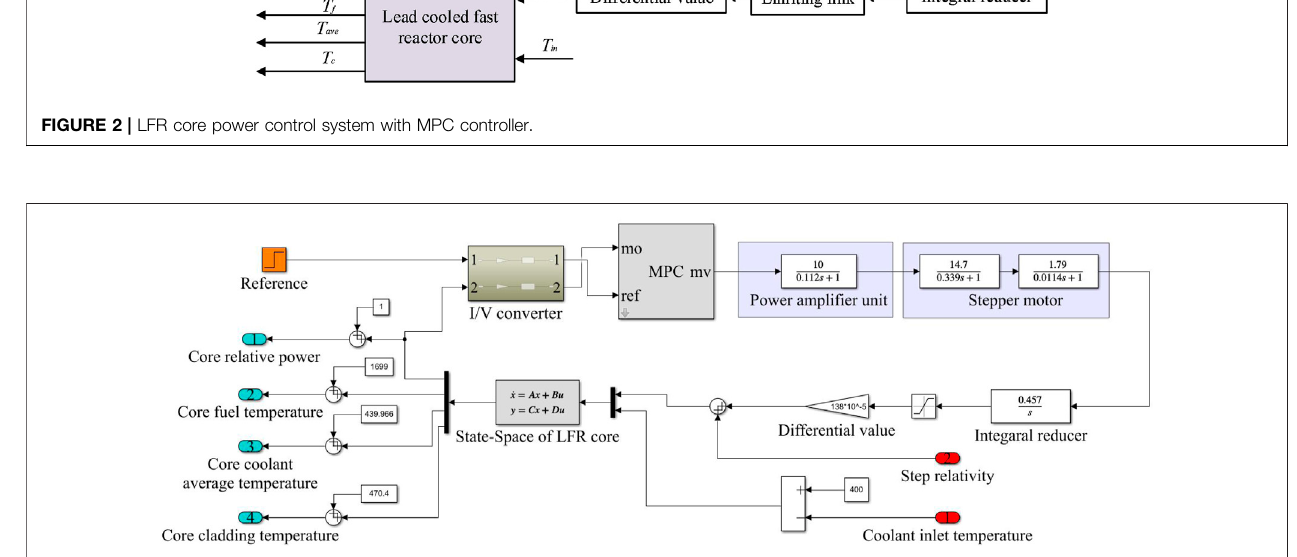
FIGURE 3 | Core power control system with MPC controller of